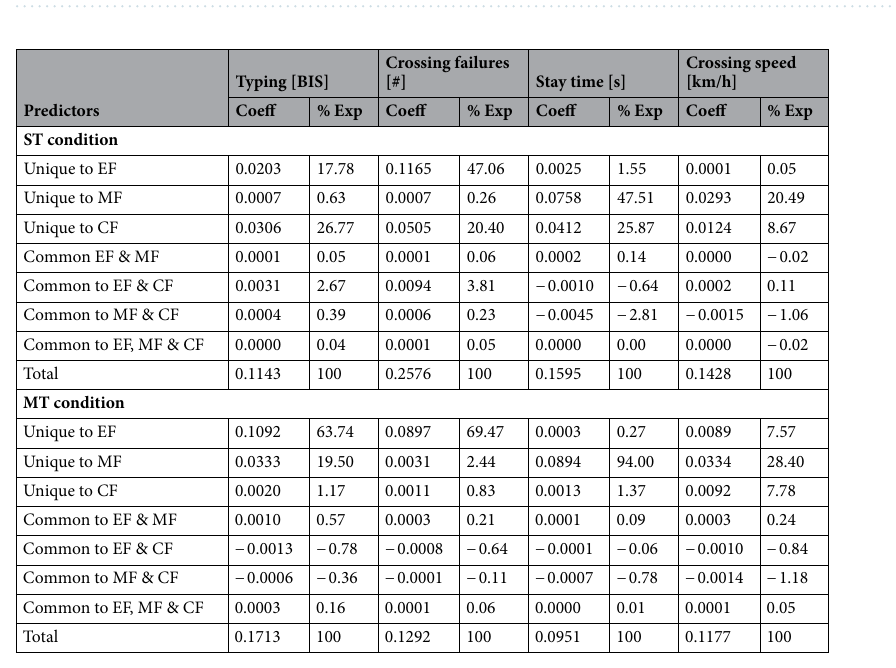
Figure 2. Graphical representation of the unique and shared variance of executive functions, motor coordinative fitness, and cardiovascular fitness in explaining ( a ) typing, ( b ) crossing failures, ( c ) stay time, and ( d ) crossing speed during single- and multitasking. EF = executive functions, MF = motor coordinative fitness, CF = cardiovascular fitness, MT = multitask condition, ST = single-task condition.